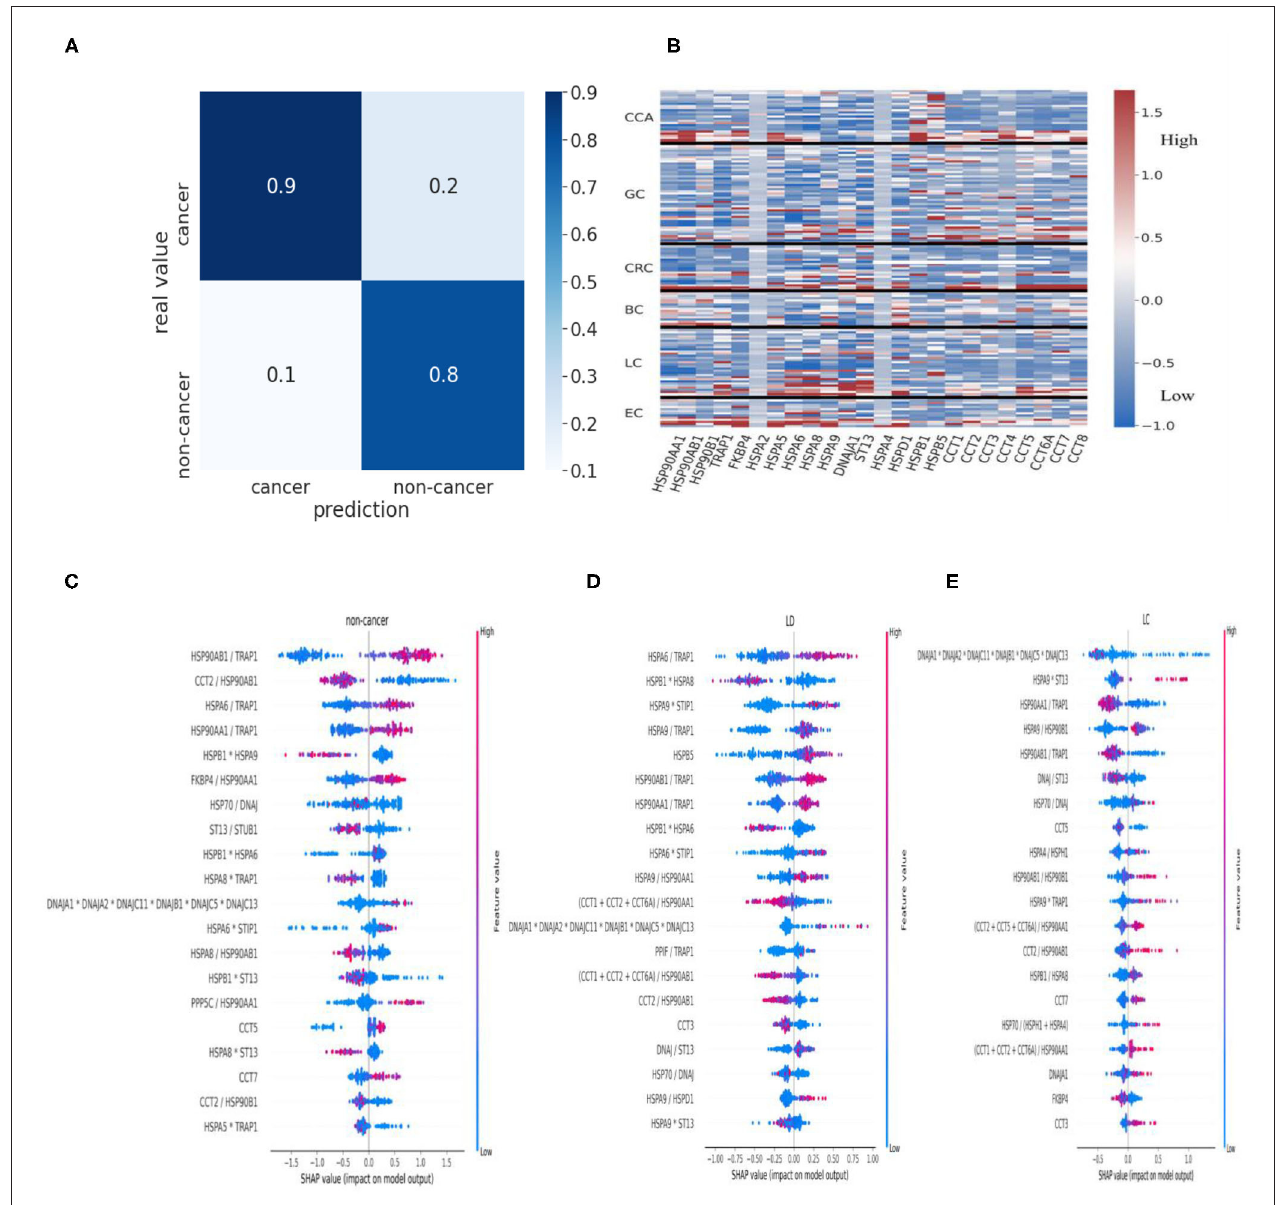
FIGURE 1 | HSPs in urine as biomarkers of cancer. (A) Confusion matrix for the cancer prediction model. (B) Heatmap of z-score normalized HSP expression levels in the urine of the patients with different types of cancer. Values were clipped to the 1st percentile of the z -scores and to the 97th percentile to minimize the effect of outliers. (C) HSPs and cochaperones in cancer and non-cancer patients. Negative values indicate a positive contribution of specific proteins to the probability that a patient has cancer. Positive SHAP values indicate that the corresponding values of the proteins are associated with lower chances of the patient having cancer. For simplicity, we presented HSPA2 + HSPA6 + HSPA8 + HSPA12 + HSPA5 as “HSP70” and DNAJA1 + DNAJA2 + DNAJC11 + DNAJB1 + DNAJC5 + DNAJC13 as “DNAJ”. (D,E) SHAP summary plots for the cancer prediction model. HSPs in urine were used to identify the critical proteins and the protein ratios in patients with benign